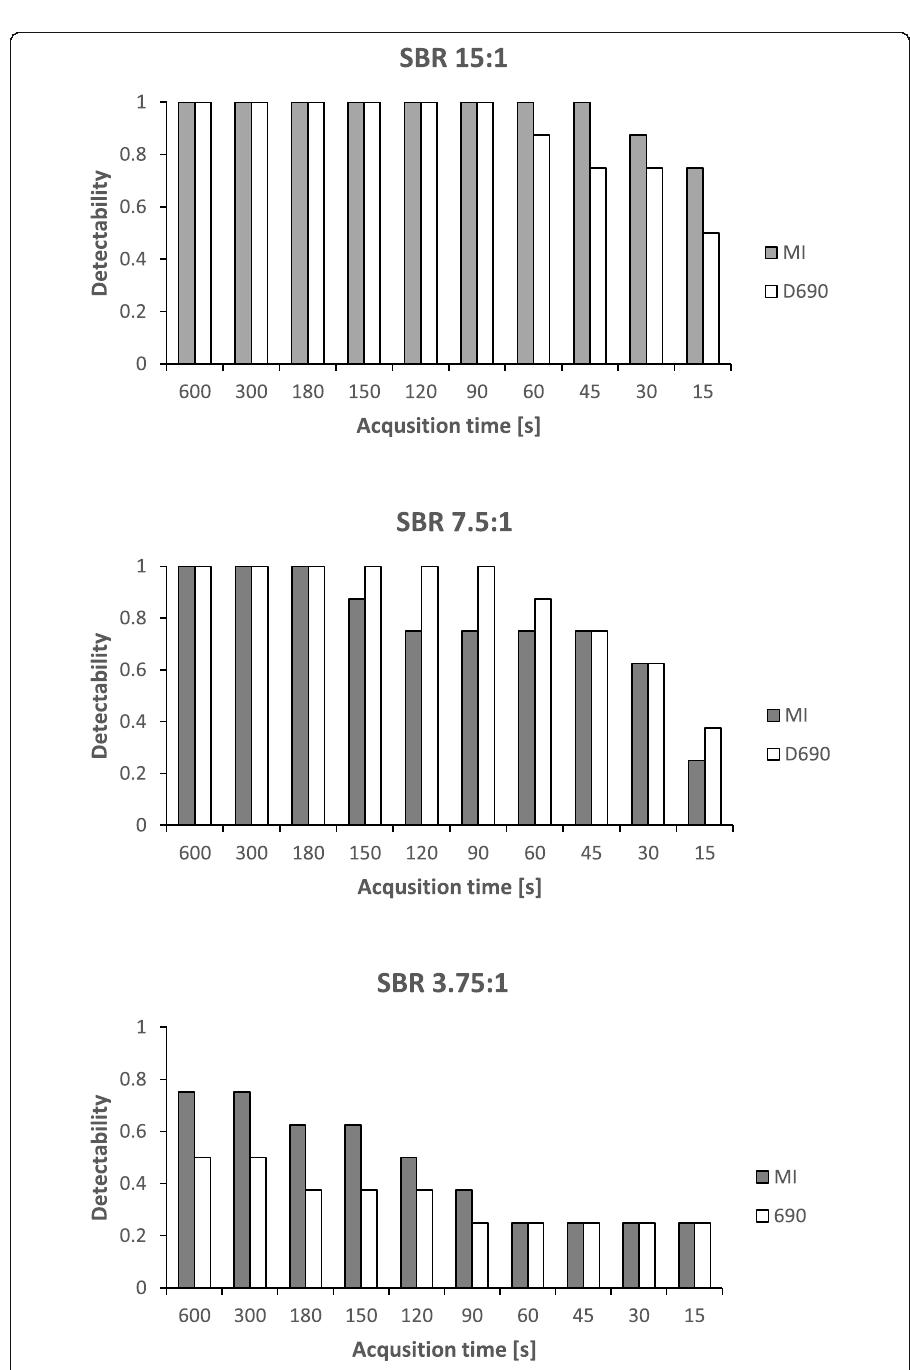
Fig. 5 Detectability of the small spheres in the Jaszczak phantom at different sphere-to-background ratios (SBRs) and different acquisition time for the Discovery MI and Discovery 690